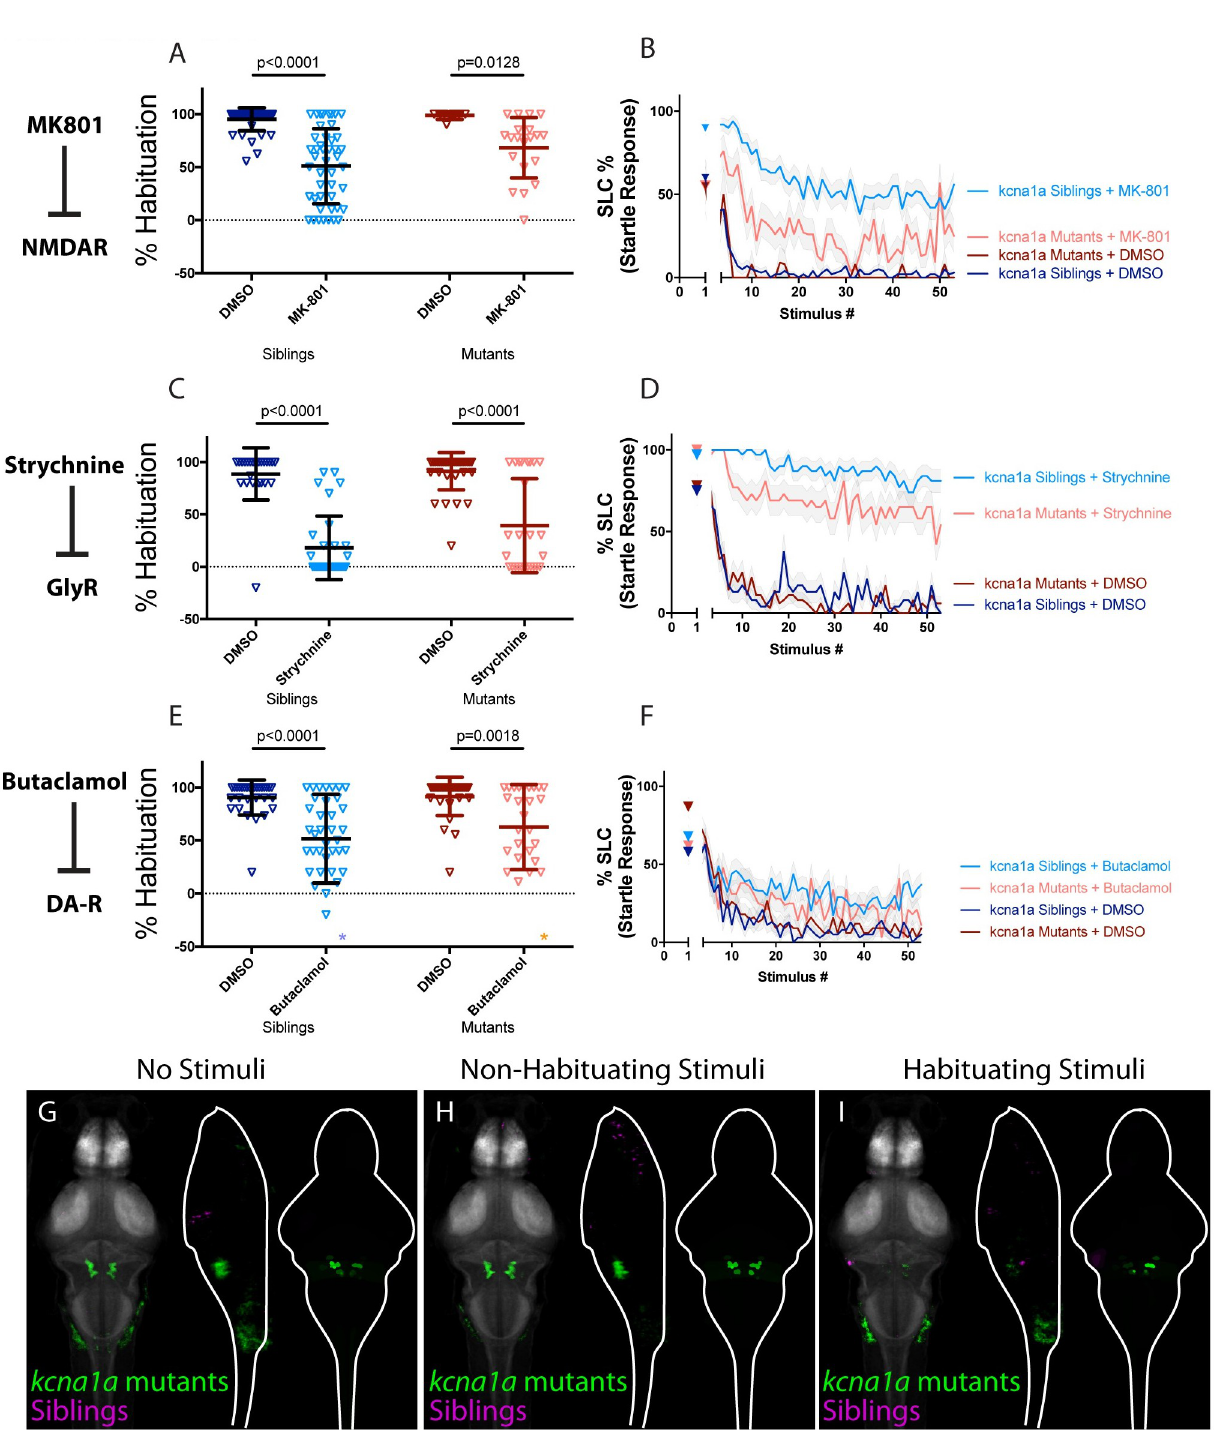
Fig 3. Kv1.1 exhibits a unique activity signature and acts independently of NMDA, glycine, and dopamine signaling. (A-B) MK-801 significantly enhances habituation learning deficits in kcna1a mutants and siblings (p < 0.0001, n = 42 DMSO-siblings, n = 46 MK-801-siblings, p = 0.0128, n = 8 DMSO-mutants, n = 20 MK-801 mutants, p = 0.2628 indicates non-significant interaction between drug treatment and genotype). (C-D) Strychnine significantly enhances habituation learning deficits in kcna1a mutants and siblings (p < 0.0001, n = 24 DMSO-siblings, n = 31 Strychnine-siblings, p < 0.0001, n = 35 DMSO-mutants, n = 26 Strychnine-mutants, p = 0.1063 indicates non-significant interaction between drug treatment and genotype). (E-F) Butaclamol significantly enhances habituation learning deficits in kcna1a mutants and siblings (p < 0.0001, n = 30 DMSO-siblings, n = 37 Butaclamol-siblings, p = 0.0018, n = 30 DMSO-mutants, n = 27 Butaclamol-mutants, p = 0.3942 indicates non-significant interaction between drug